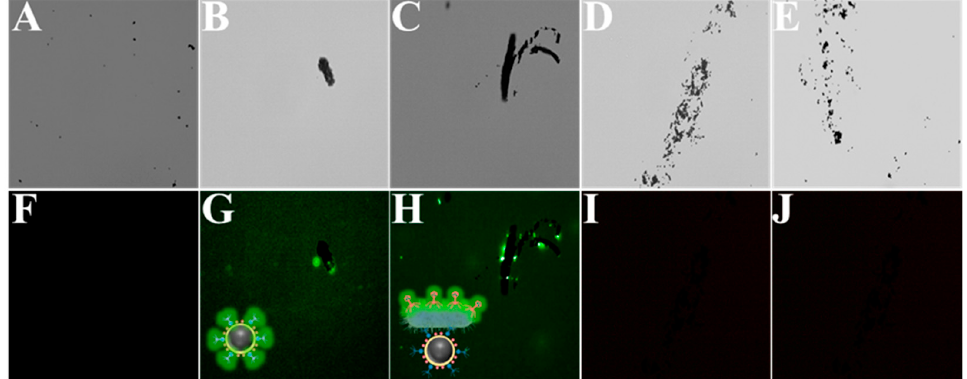
Figure 2. ( A – E ) The brightfield of MBs, M-P1, M-P1@S.T@P2-S, M-P1@ E.coli @P2-S, and M- P1@S.A@P2-S, respectively. ( F – J ) correspond to their fluorescent field,